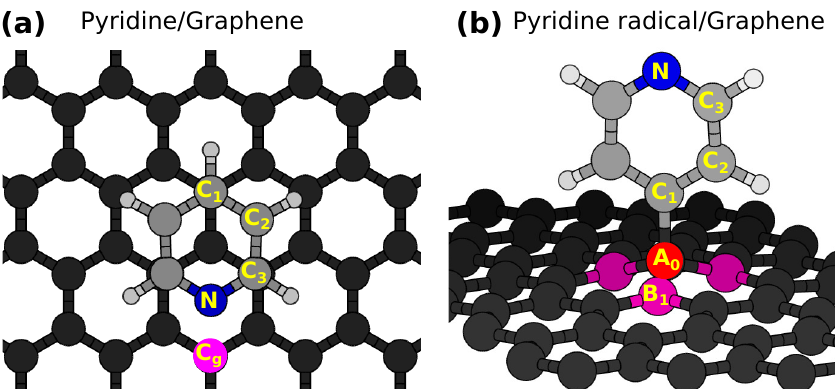
Figure 1. The stable configurations of ( a ) pyridine on graphene and ( b ) the pyridine radical on graphene. C1, C2 C3 are the three inequivalent C atoms of the molecule in the gas phase; the blue sphere stands for the N atom and the smaller gray ones for the H atoms. C g in ( a ) (magenta) is one of the carbon atoms of graphene close to the N atom of the molecule for which Near Edge X-ray absorption Fine Structure (NEXAFS) spectra are calculated. In ( b ), A 0 is the C atom of graphene that participates in the covalent bond with the molecule. By B 1 , we label the C atoms that are the nearest neighbors to the A 0 site and that belong to the other inequivalent sublattice of